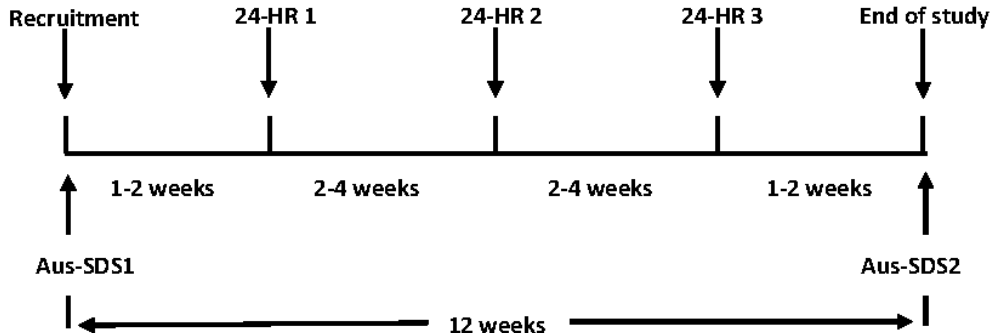
Figure 1. Timeline of study. Three 24-hour recalls (24-HRs) were administered at intervals of 2–4 weeks, commencing 1–2 weeks after the first Australian Short Dietary Screener (Aus-SDS1) was administered. Aus-SDS2 was administered 1–2 weeks after completion of the final 24-HR. Total study duration was 12 weeks.